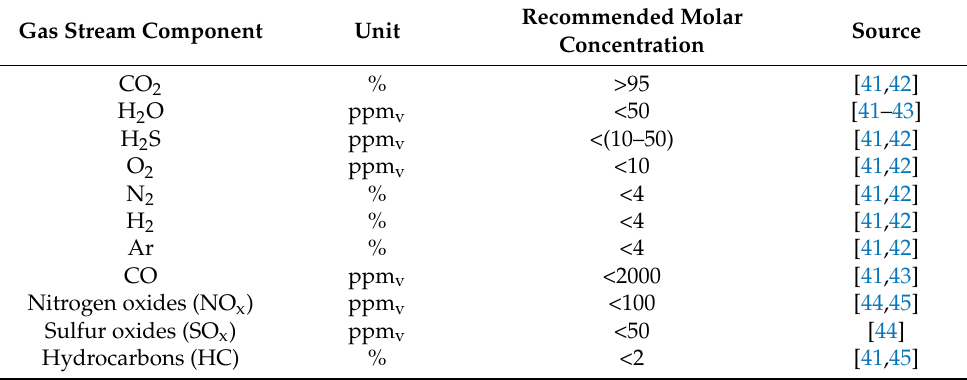
Table 1. Recommended permissible concentrations of relevant components of the gas stream for further